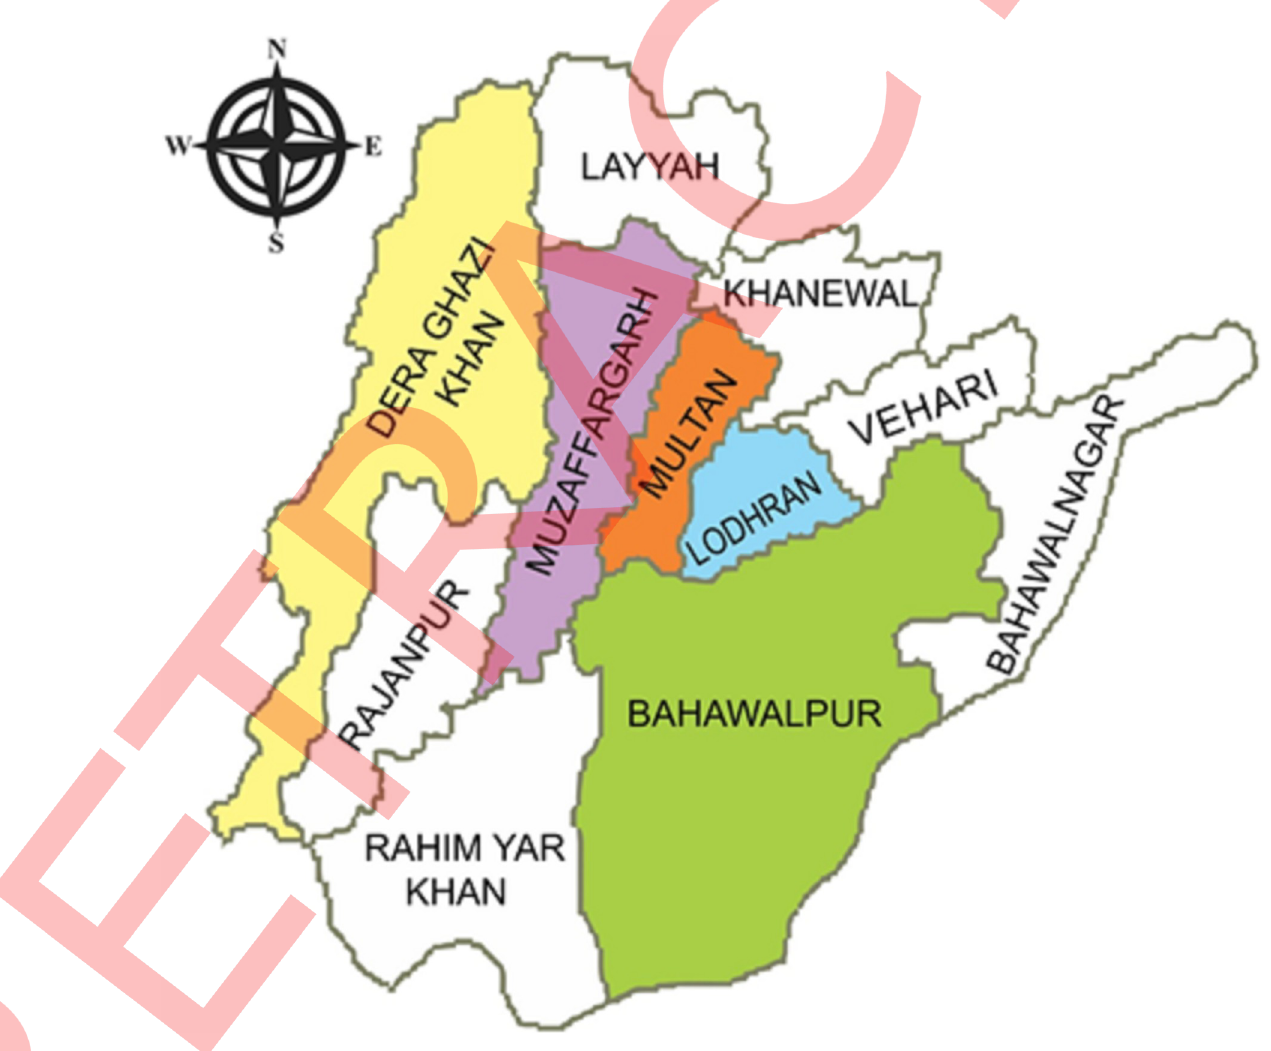
Fig 1. Map showing five major districts (shaded) of South Punjab–Pakistan covered for surveillance and antibacterial resistance in Salmonella isolates from raw milk and